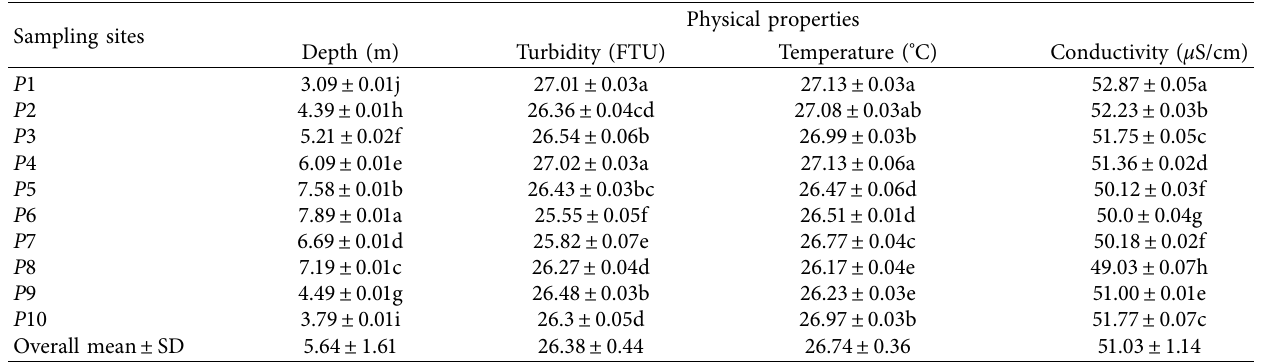
Table 1: Physical properties of Dembi reservoir water ( n �